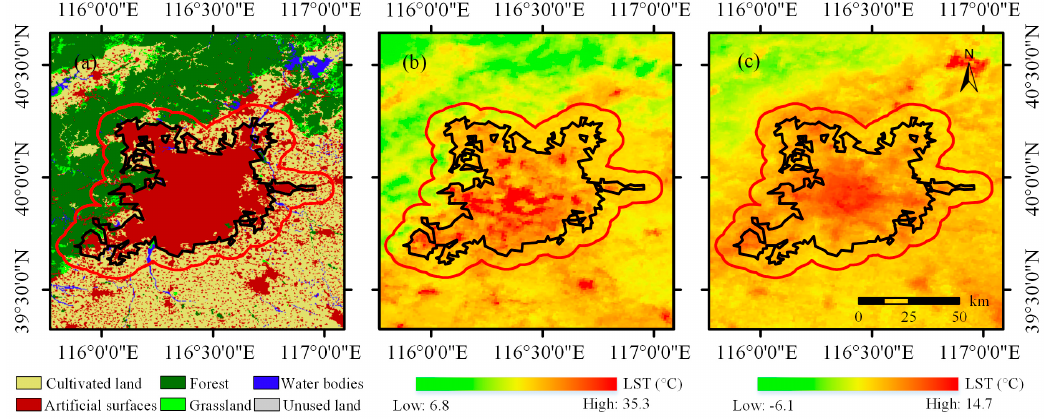
Figure 2. The delineation of urban and suburban areas, an example of Beijing. ( a ) Land cover/use map in 2010 with a spatial resolution of 30 m; ( b ) the annual mean daytime land surface temperature (LST) (°C); and ( c ) the annual mean nighttime LST (°C) in 2010. The black lines stand for the border of the urban area, and the regions outside the black line but within the red line represent the suburban area that covers the same area of the urban extend (excluding water pixels).